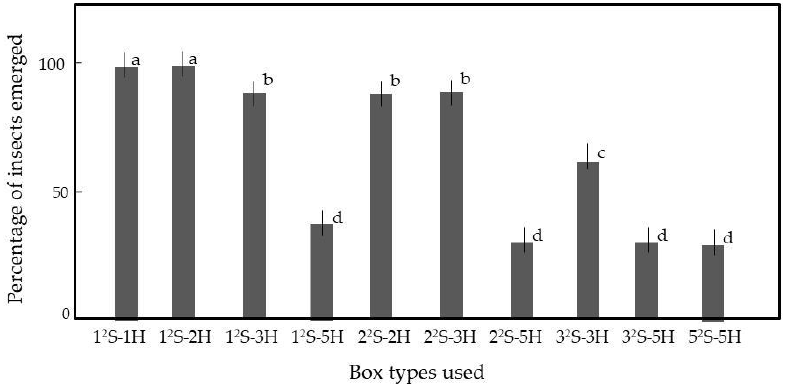
Figure 4. Emergence of adult rice weevils from rice grains in cells of various sizes. Rice grains were mixed with 50 weevils. Table S1 provides the box details. Means and standard deviations of five replicates are shown. Letters (a–d) on a column indicate significant differences ( p < 0.05), as revealed by the Tukey method.